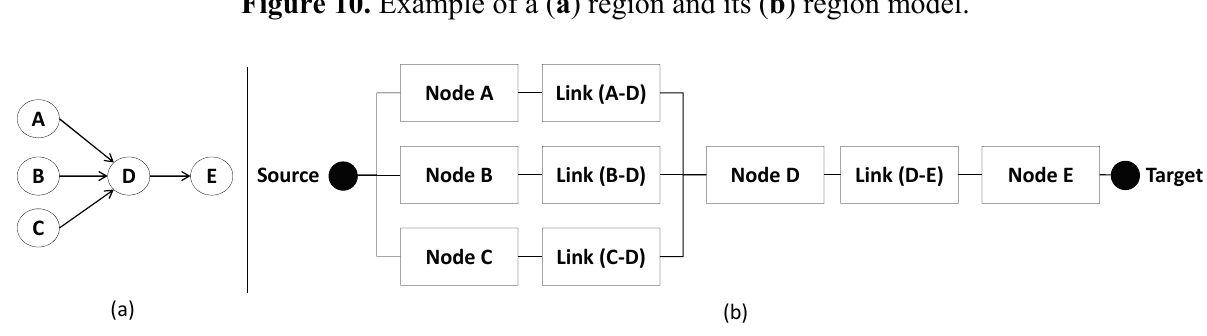
Figure 10. Example of a ( a ) region and its ( b ) region